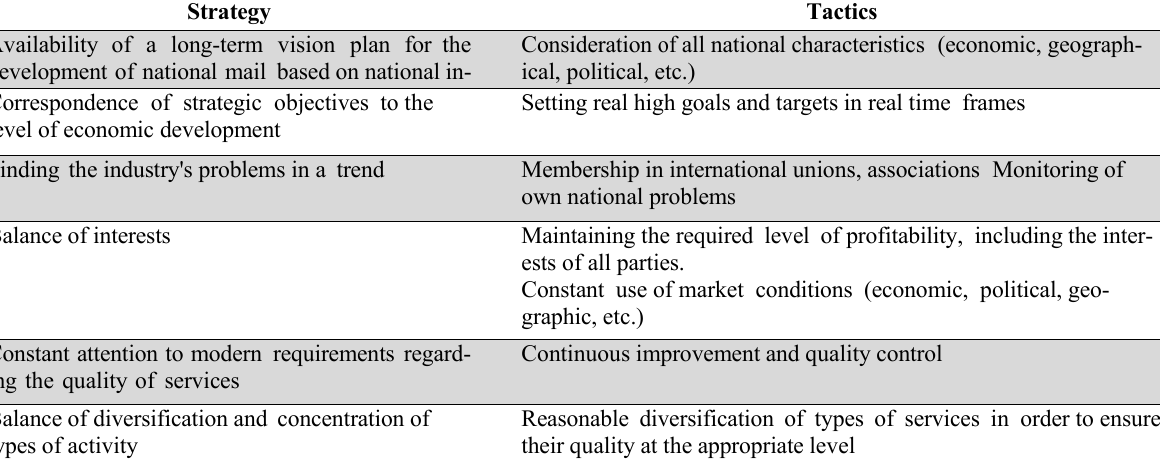
Basic directions for adjusting the marketing strategies of mail in developing countries Strategy Tactics Availability of a long-term vision plan for the Consideration of all national characteristics (economic, geograph- development of national mail based on national in- ical, political,